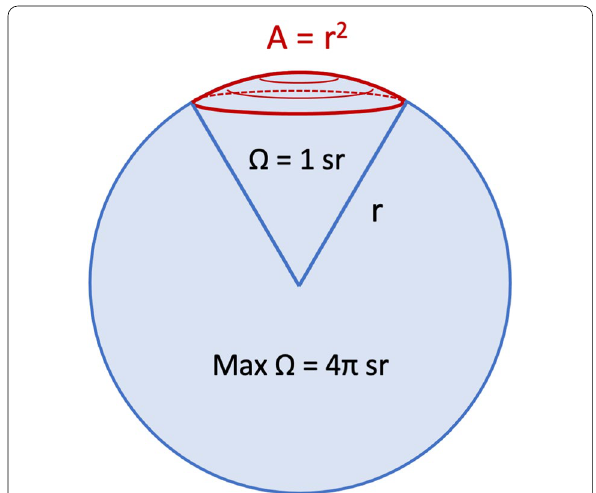
Fig. 14 Illustration of the steradian dimensionless unit used to define the backscatter coefficient. The solid three-dimensional angle Ω corresponds to the area A divided by the radius squared of the